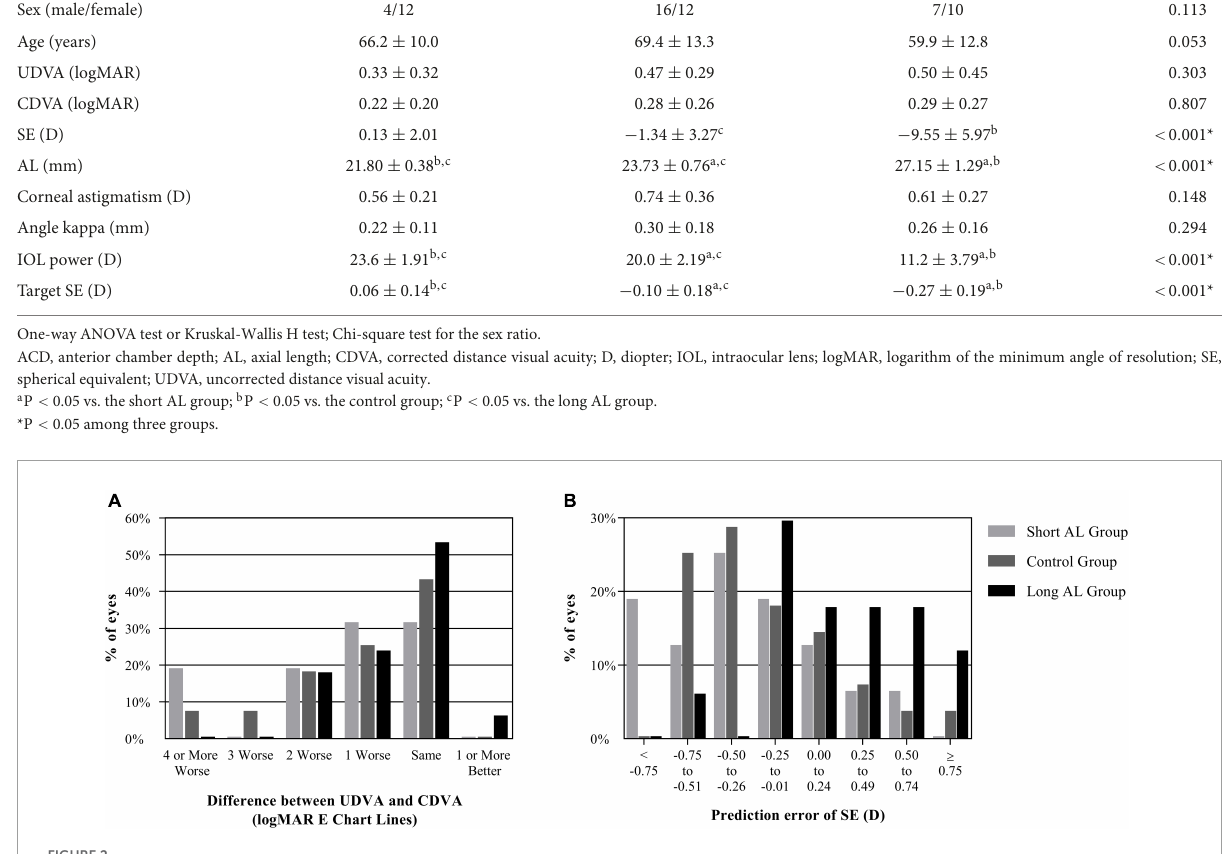
FIGURE2 The refractive outcomes of three groups. (A) Difference between UDVA and CDVA; (B) prediction error of SE. (AL, axial length; CDVA, corrected distance visual acuity; logMAR, logarithm of the minimum angle of resolution; SE, spherical equivalent; UDVA, un corrected distance visual